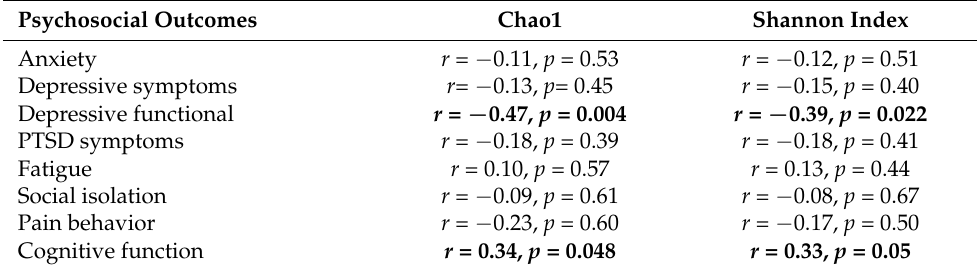
Table 3. Associations between alpha diversity and psychosocial